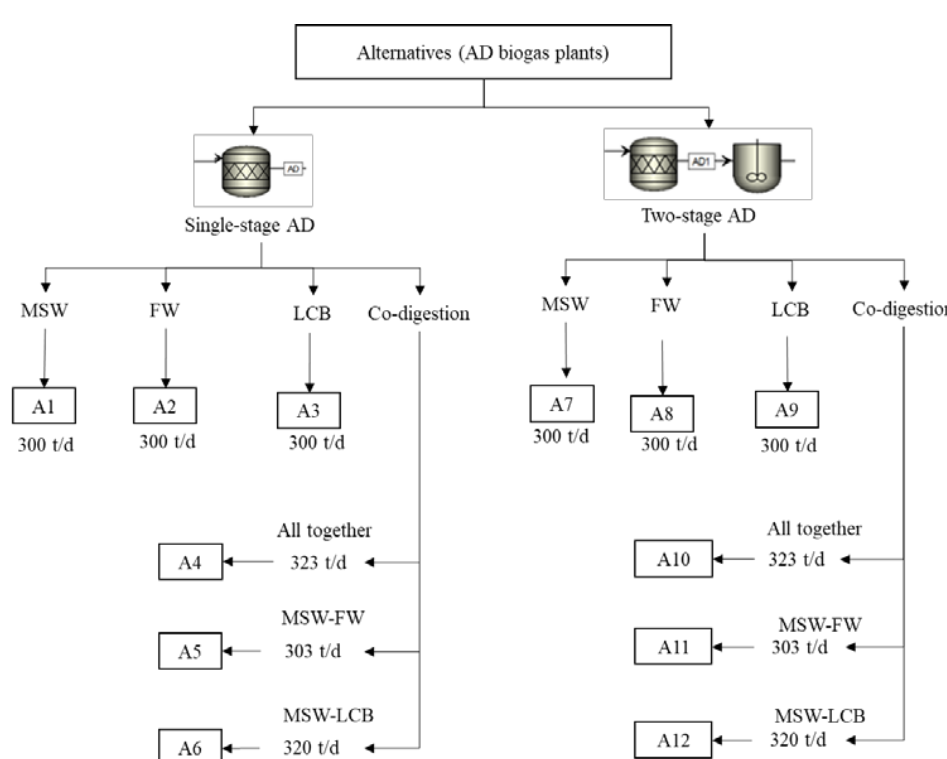
Figure 2. Biogas AD plants simulated in Aspen Plus: Alternatives evaluated through MCA.